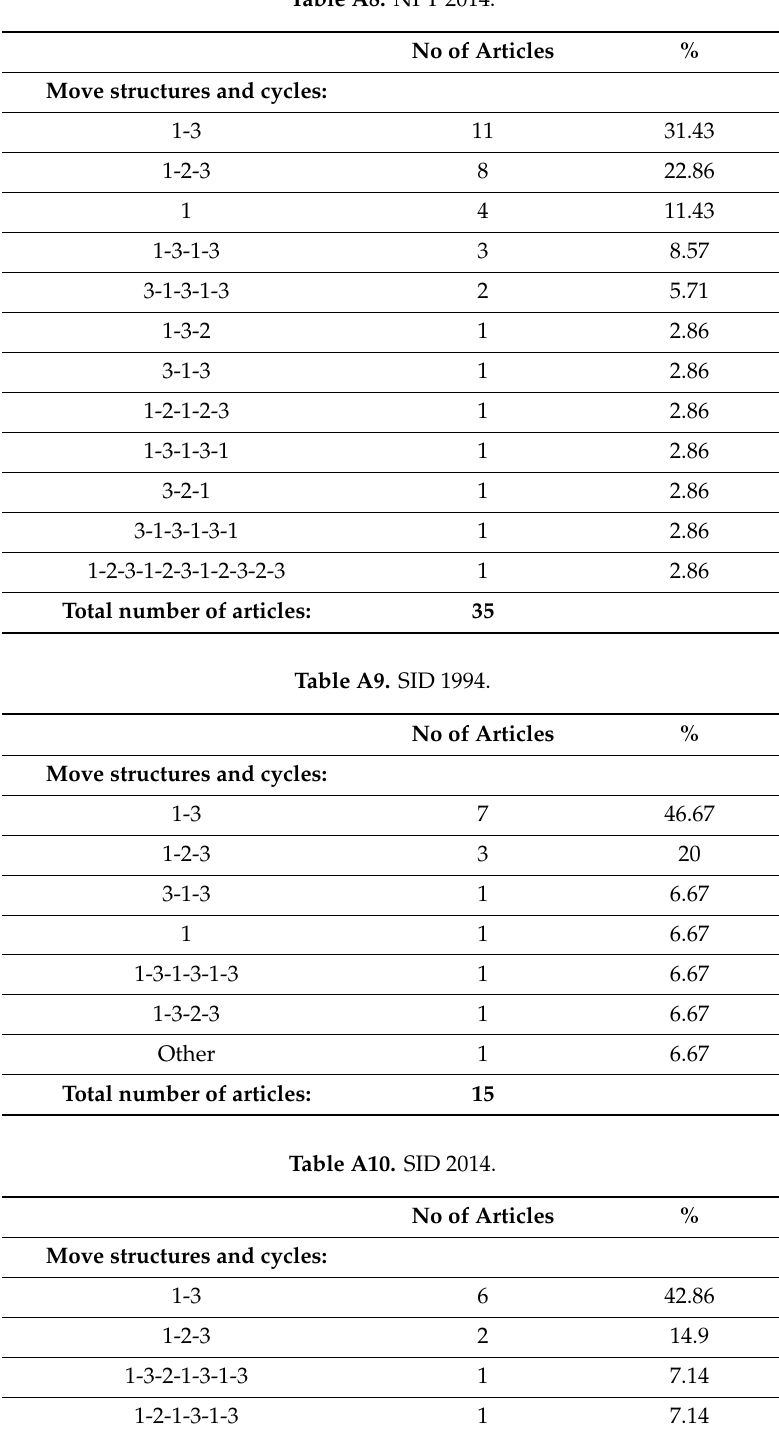
Table A8. NPT 2014.